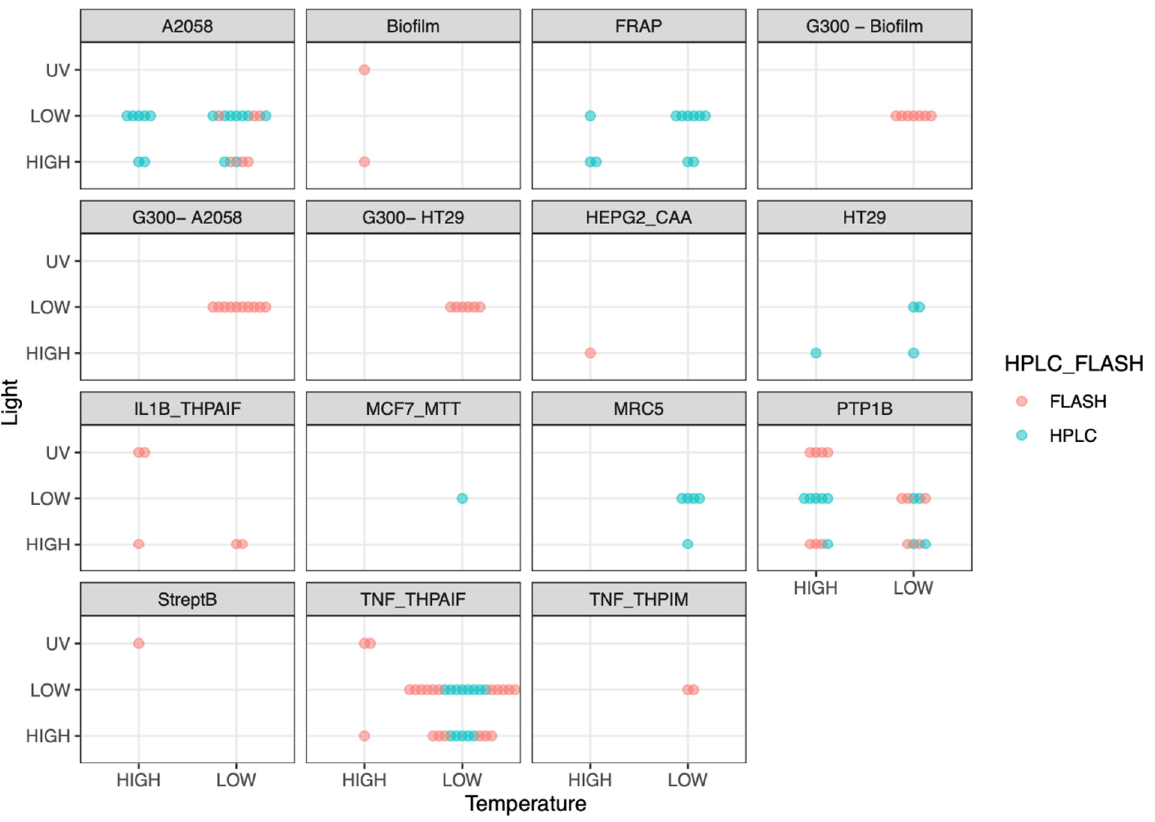
Figure 17. Overview of positive results (hits) from testing diatom biomass in bioactivity assays. Highlighted here is the fractionation method (FLASH vs. HPLC). Results from assays G300–A2058, G300-Biofilm and G300–HT29 were reported in Osvik et al. [104], and HPLC fractioned extracts tested in A2058, FRAP, PTP1B and TNF THPAIF/IM assays were reported in Ingebrigtsen et al. [107]. The figure was made using RStudio Version 1.4.1106.